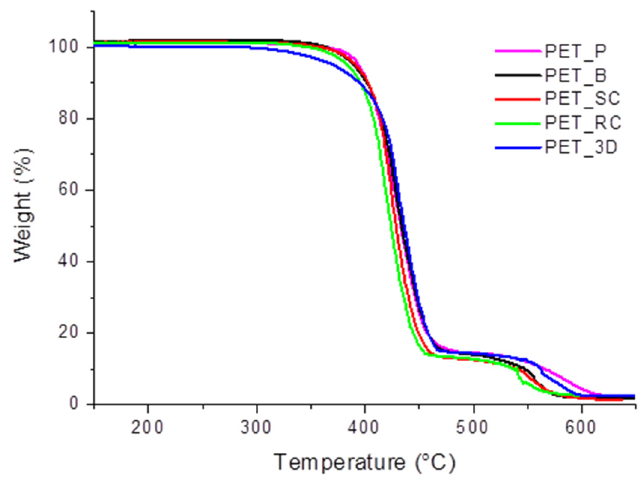
Figure 6. TGA curves on PET samples. Table 3. Tonset and solid residue from TGA